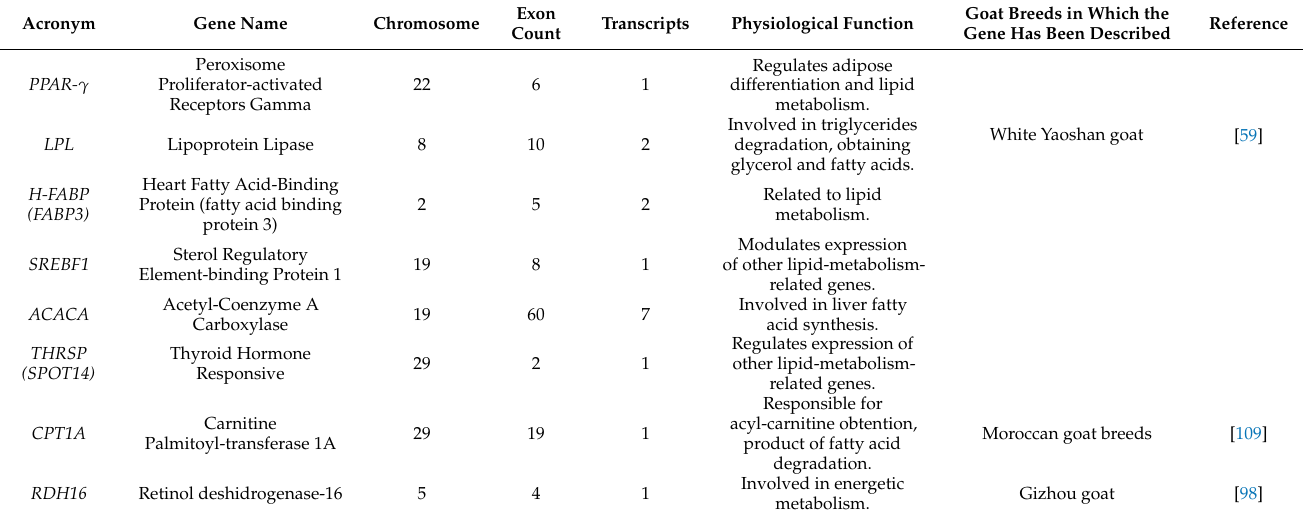
Table 4. Summary of the candidate genes associated with carcass lipidic profile that have been described in goat breeds, their chromosome location, exon counts, physiological function and where to find them in the